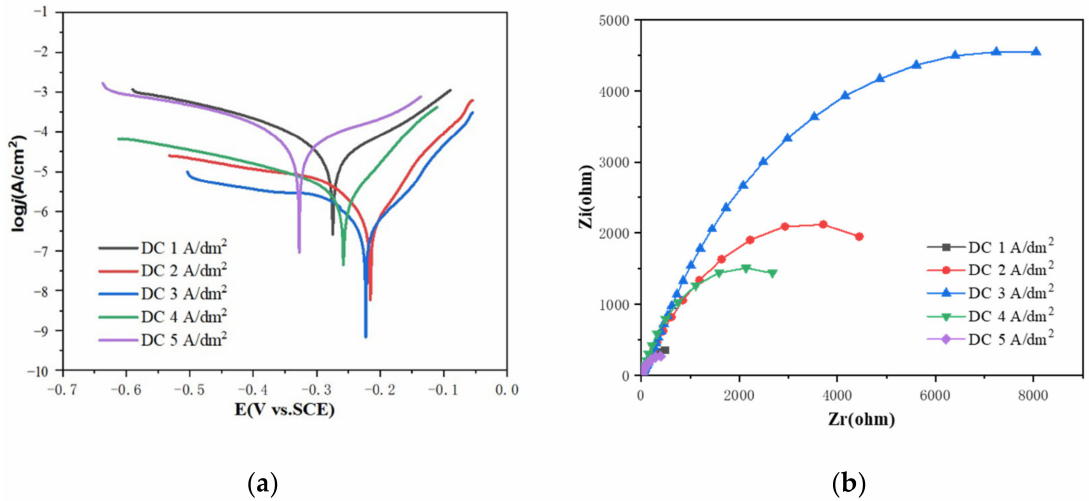
Figure 5. Tafel polarization curves ( a ) and Nyquist plot ( b ) of the Ni-Co/WS 2 nanocomposite coatings prepared under different current